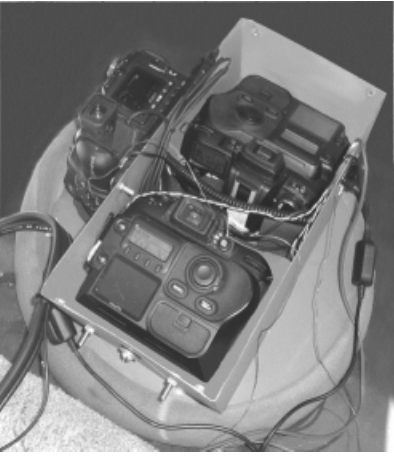
Figure 2. Dual head system with two Fuji S3 Pro cameras.